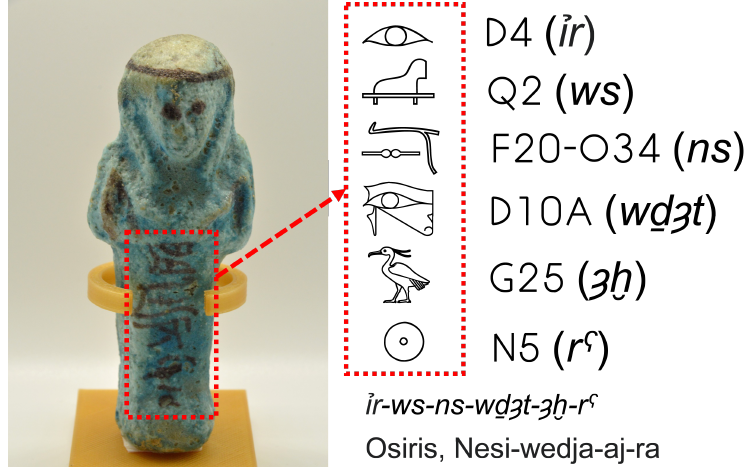
Figure 2. Inscribed shabti of Nes-oudja-aj-ra using Gardiner code [40]. Private collection. XXI-XXII dynasty (1085 BC–713 BC). Third Intermediate